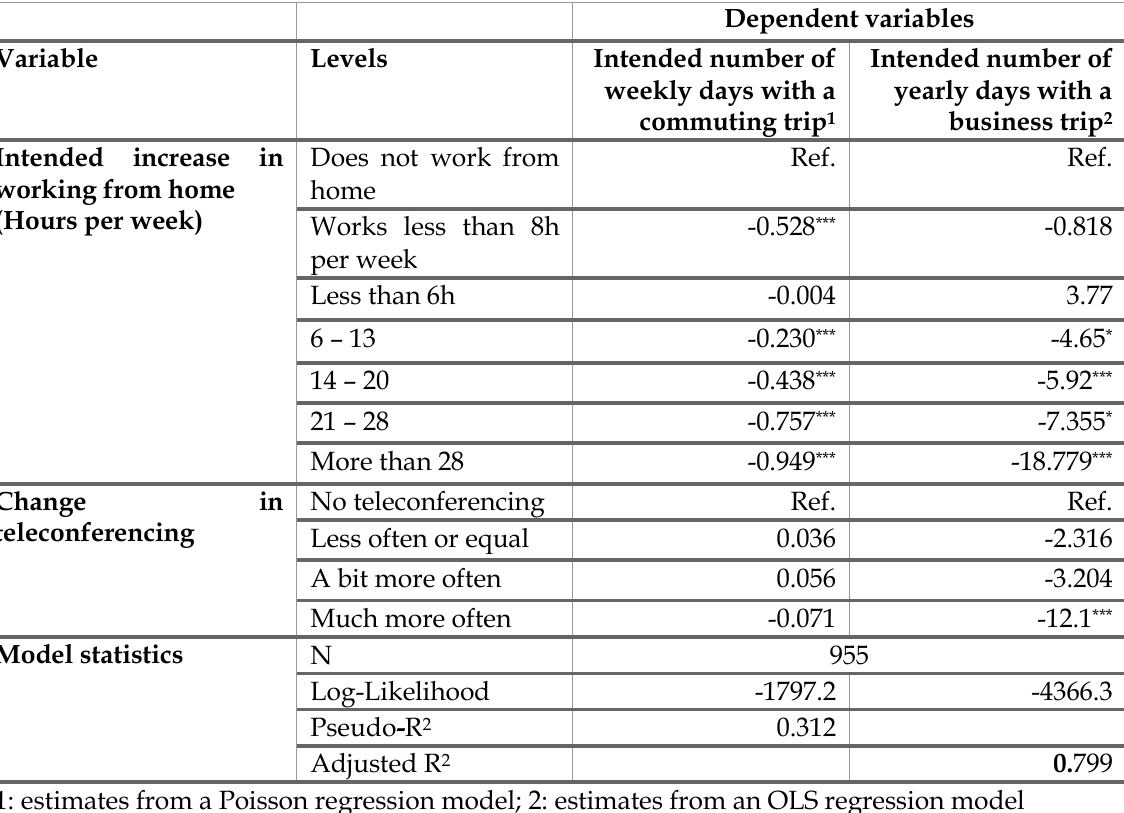
Table 2. Parameter estimates of working from home and teleconferencing on intended travel behaviour (Model based on data from MPN